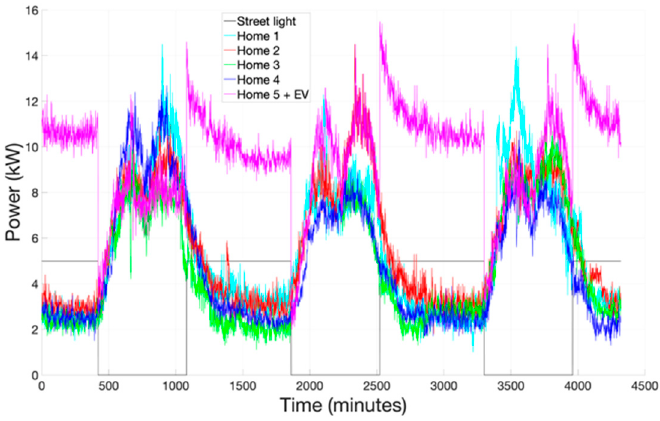
Figure 6. Electricity demand (low voltage).